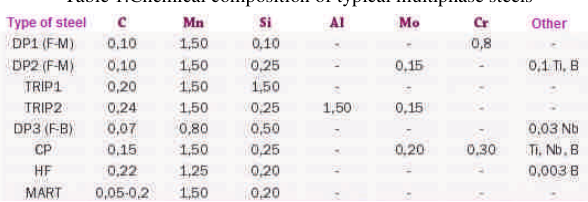
Fig. 7. The influence of the alloy elements on selected microstructural fea- tures and mechanical and technological properties of multiphase steels [6] Table 1.Chemical composition of typical multiphase